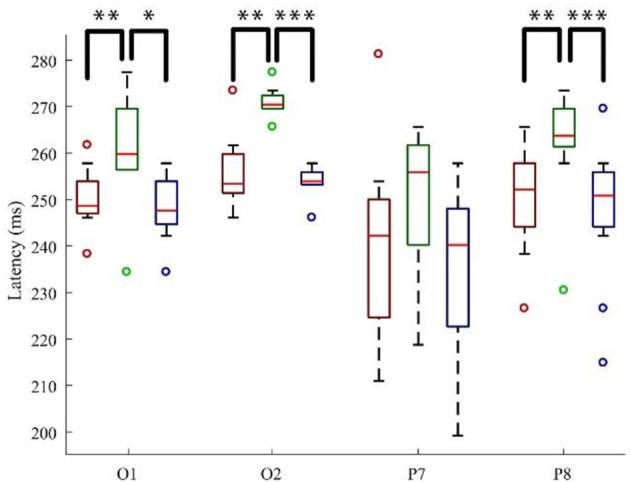
The N200 latency boxplot with significance at four sites. Note: the label “*” means the significance of two groups is p < 0.05; meanwhile, **p < 0.01 and ***p < 0.001; the color of the box indicates the corresponding paradigm.